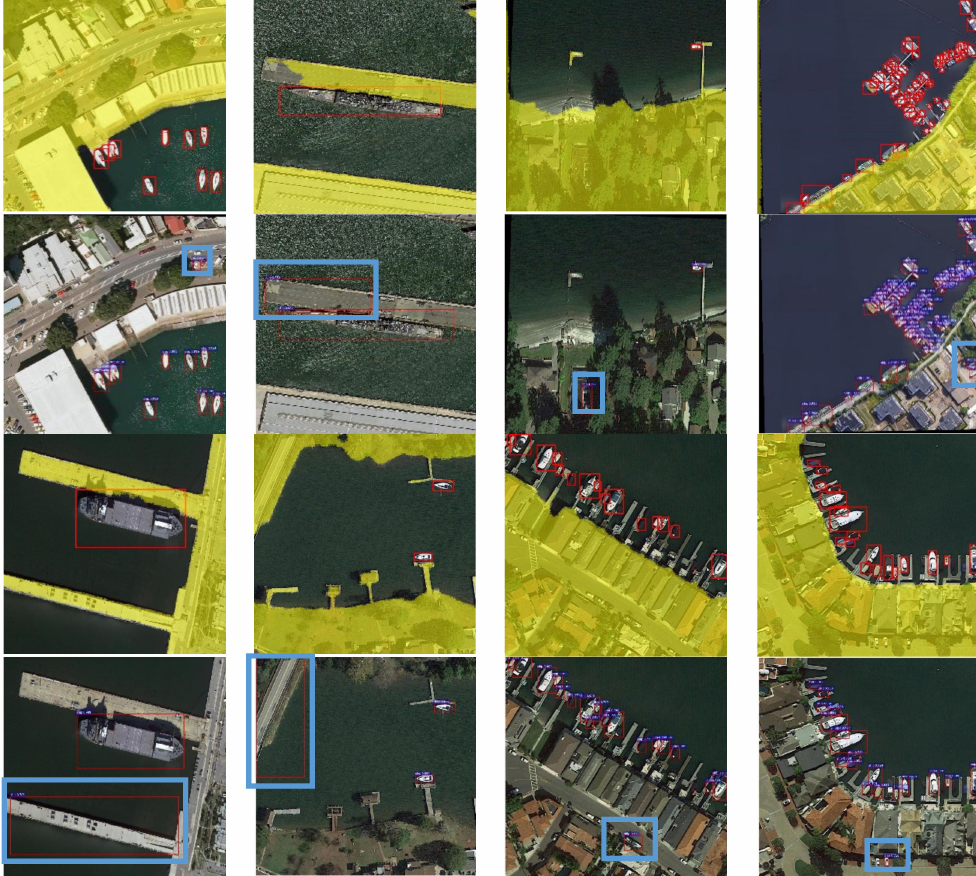
Figure 20. The comparison results of the Mask-Faster R-CNN and baseline method. The first and third row are results of the Mask-Faster R-CNN, the second and forth row are results of the Faster